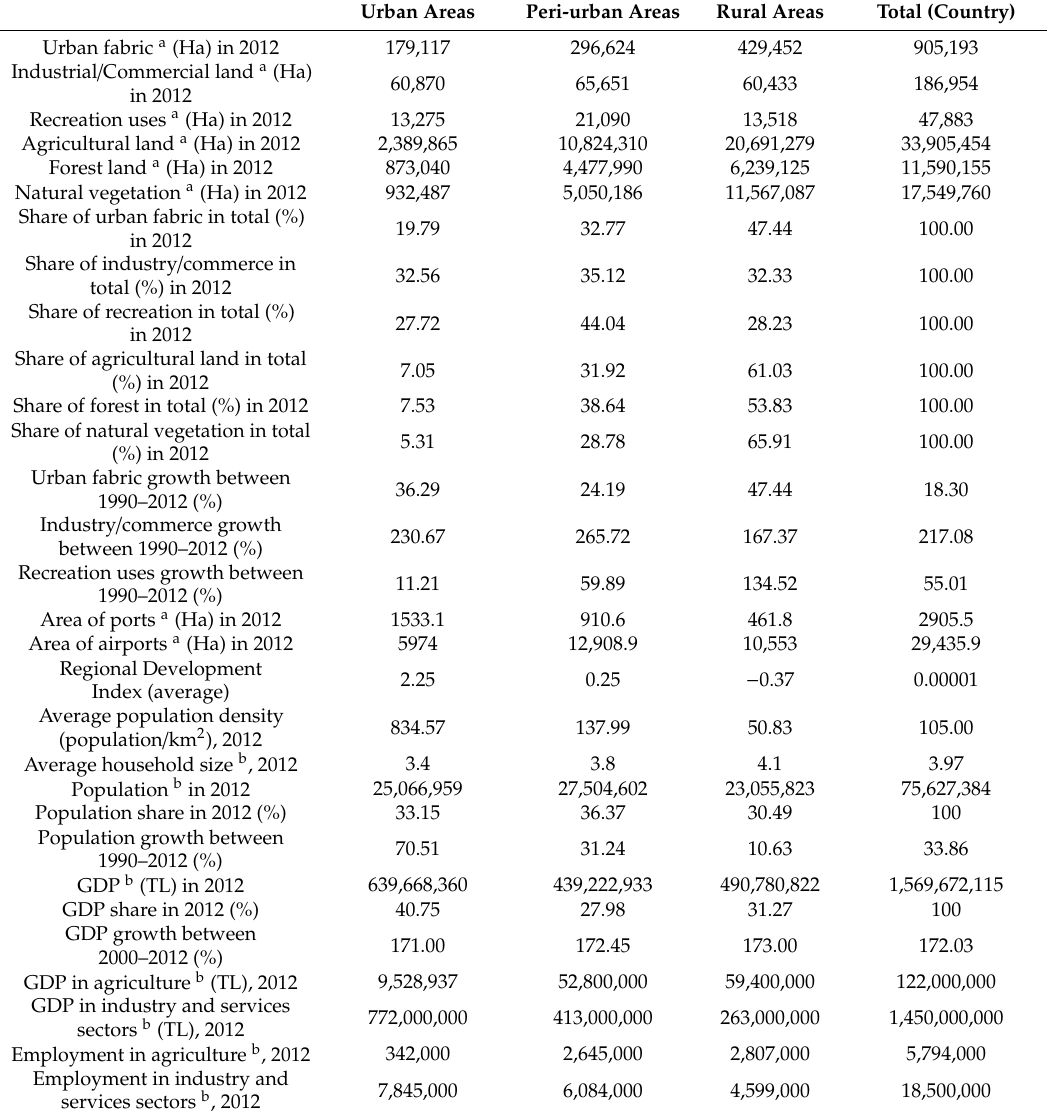
Table 2. Statistics on land-use and socio-economic data in Turkey. Urban Areas Peri-urban Areas Rural